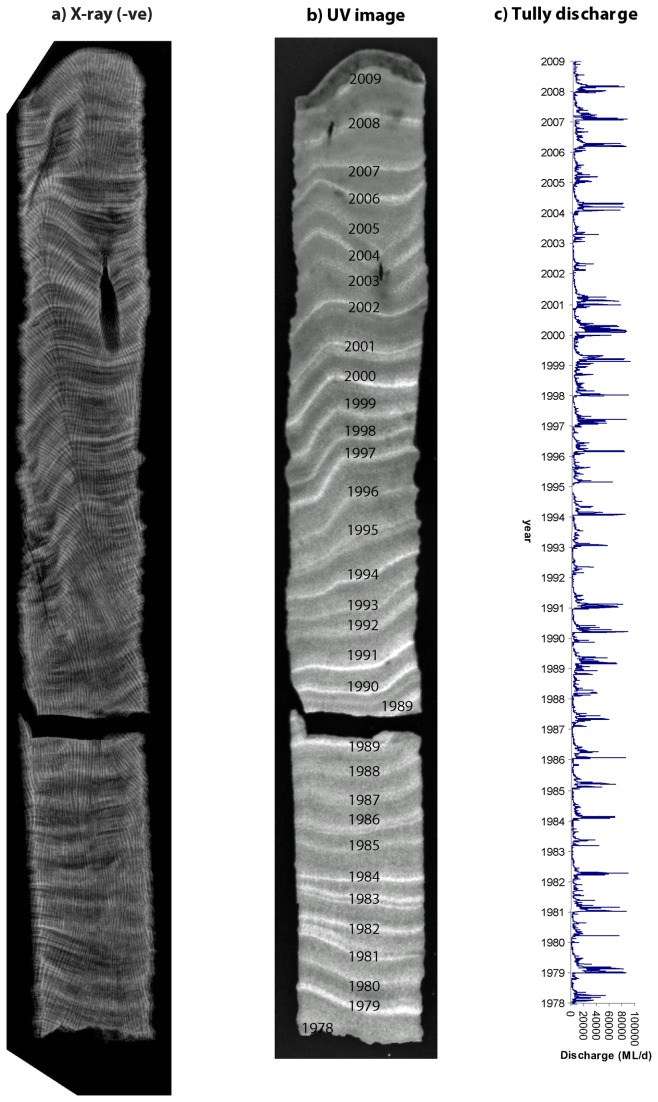
Coral chronologies determined from: (a) X-ray image displaying density bands; (b) image taken under UV light displaying luminescent lines of flood events, and (c) Tully river discharge (ML d-1).